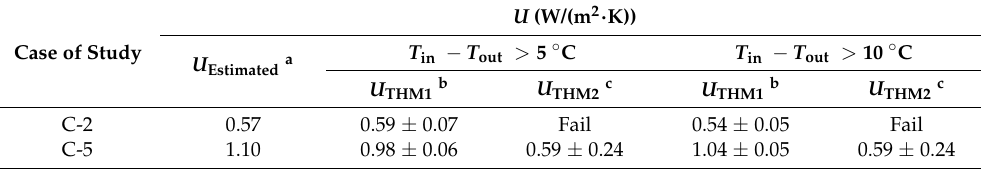
Table 5. Comparison of the obtained values of thermal transmittance in C-2 and C-5 according to data management.